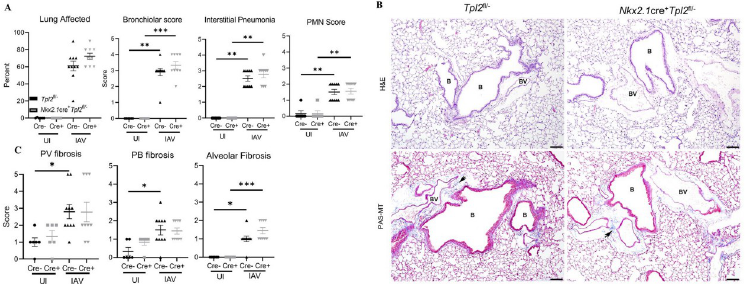
Fig 4. Nkx2 . 1 cre + Tpl2 fl/- mice have normal pulmonary histological profiles at 7 dpi with influenza A virus. (A) Inflammation scoring of Tpl2 fl/- and Nkx2 . 1cre + Tpl2 fl/- mice at 8.5 dpi with 10 4 PFU influenza A/x31. Lungs sections were stained with hematoxylin and eosin and scored by a pathologist blinded to sample identity. Tpl2 fl/- , N = 16 (6 controls, 10 experimental). Nkx2 . 1cre + Tpl2 fl/- , N = 15 (6 controls, 9 experimental). (B) Representative images of Tpl2 fl/- and Nkx2 . 1cre + Tpl2 fl/- lung sections stained with hematoxylin and eosin (H&E) at 8.5 dpi (top panels) and Periodic Acid Schiff, counterstained with hematoxylin and Masson’s trichrome stain (PAS-MT) at 8.5 dpi (bottom panels). B (Bronchiole), BV (Blood Vessel). Arrows point to areas of fibrosis as indicated by blue staining in PAS-MT panels. Data representative of 2 experiments. (C) Fibrosis scoring. Lung sections as in B were scored for fibrosis by a pathologist blinded to sample identity. Scoring was on a scale of 1–5 of the worst affected structure relative to normal thickness. Perivascular (PV), Peribronchiolar (PB), Alveolar fibrosis. Tpl2 fl/- , N = 16 (6 controls, 10 experimental). Nkx2 . 1cre + Tpl2 fl/- , N = 15 (6 controls, 9 experimental). Data representative of 2 experiments. Error bars represent means ± SEM. � p < 0.05, �� p < 0.01, ��� p < 0.001; Kruskal-Wallis nonparametric test with Dunn’s multiple comparisons